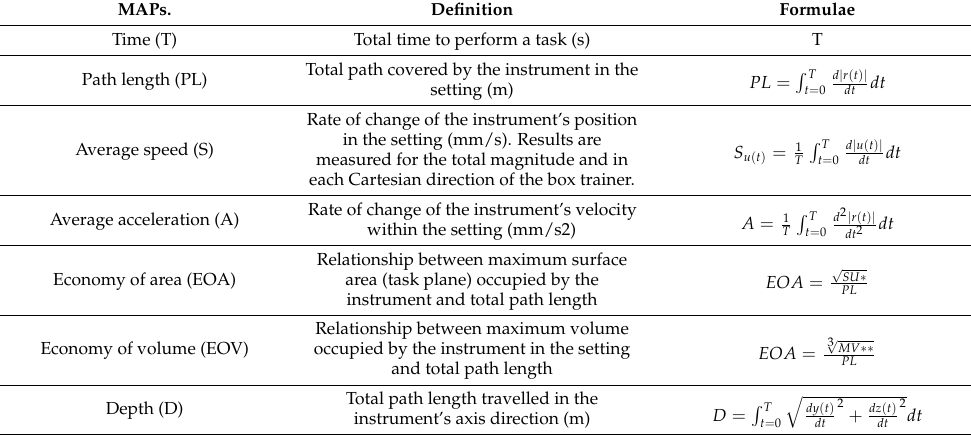
(cid:82) T d | r ( t ) | dt dt t = 0 √ SU ∗ EOA = PL √ MV ∗∗ EOA = 3 PL (cid:113) 2 + dz ( t ) 2 (cid:82) T dy ( t ) dt dt t = 0